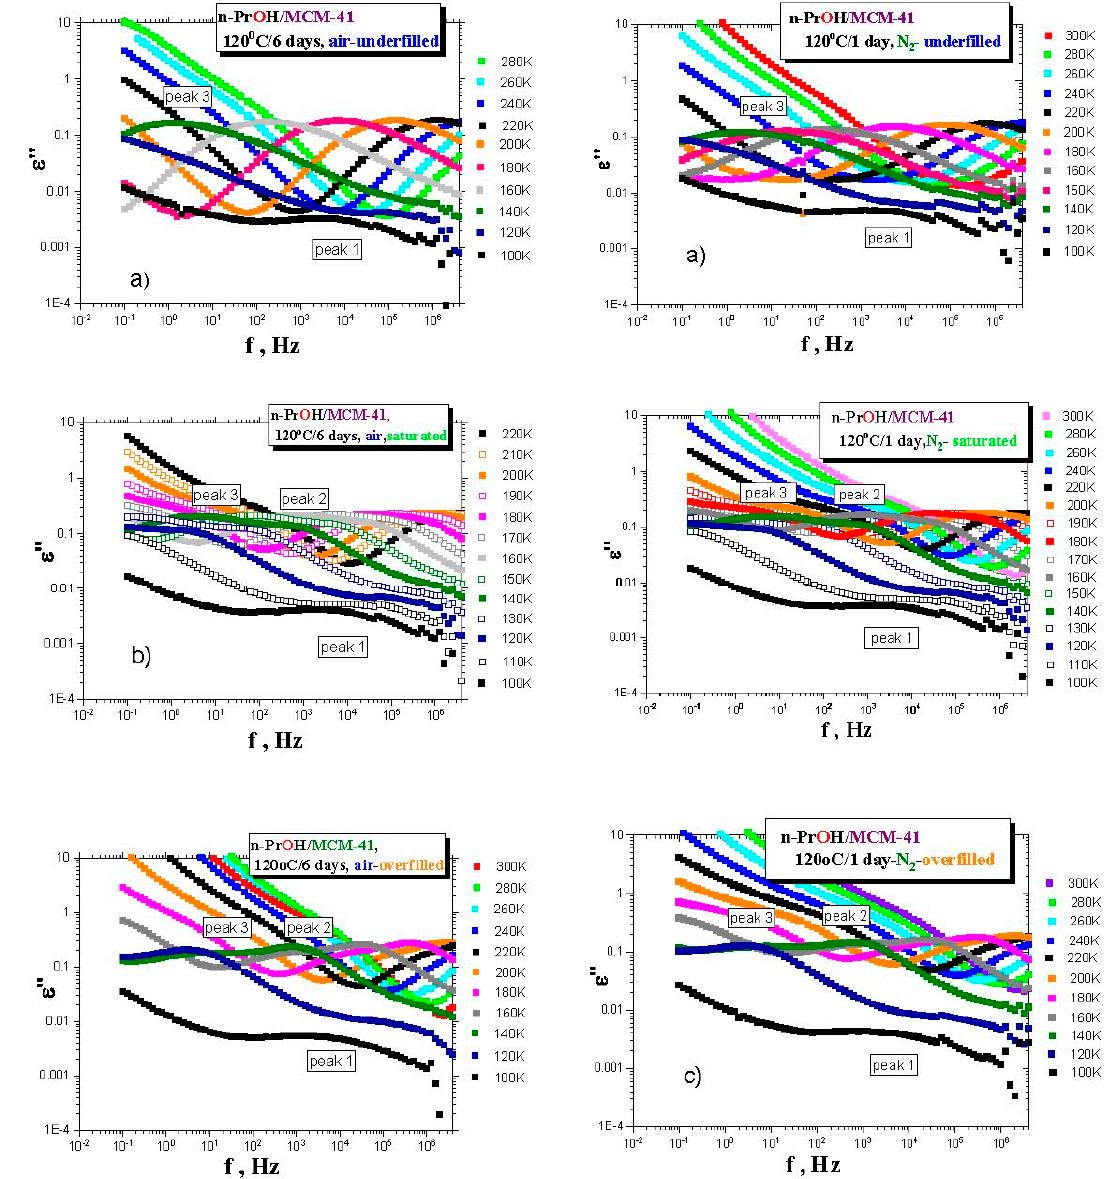
Figure 3. BDS spectral evolutions for the confined n-PrOH / MCM-41 underfilled ( a ), saturated ( b ) and overfilled ( c ) systems prepared by drying of the MCM-41 at 120 ◦ C for six days in the VO and subsequent loading of the n-PrOH medium into the capacitor under air (left column) and drying of the MCM-41 at 120 ◦ C for one day in the VO and subsequent loading of the n-PrOH medium into the capacitor under N 2 (right column) The samples were cooled with − 2 K / min from RT down to 100 K and subsequently, isothermally heated with ∆ T = 5 K from 100 K up to 280–300 K.